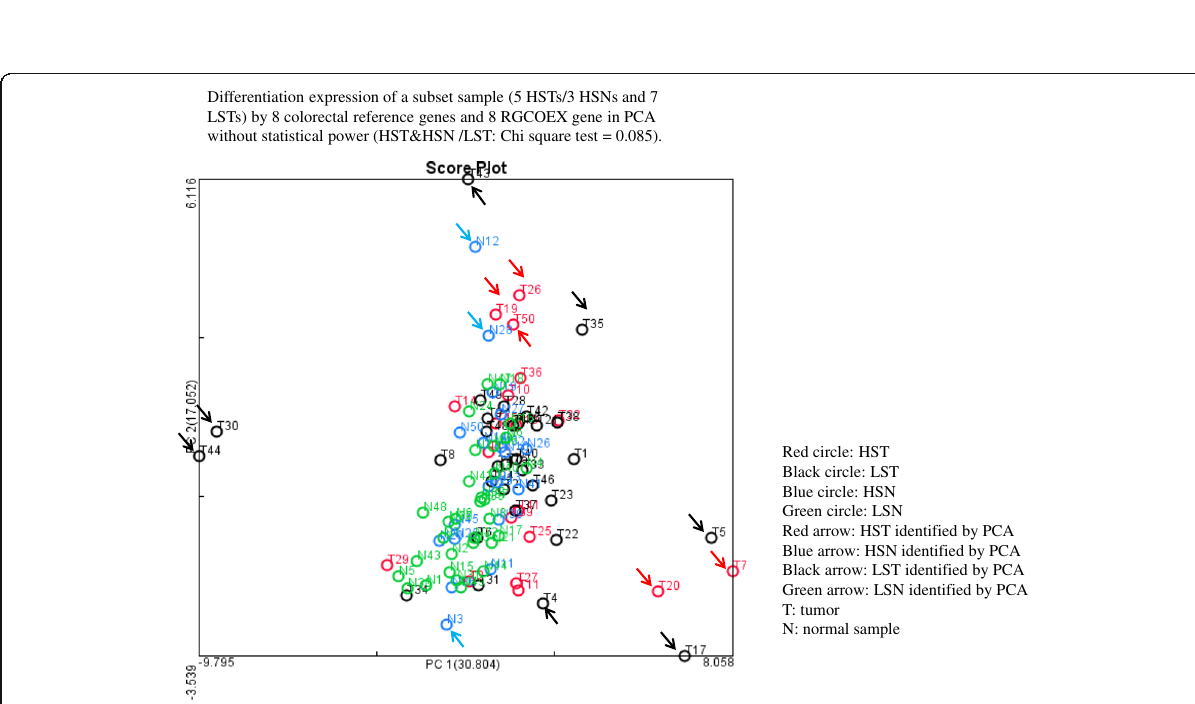
Fig. 5 HCA and PCA analysis of reference genes in 50 CRC pairs (TCGA). a . Differential expression of 21 classical reference genes among 50 CRC pairs (TCGA) in HCA. b . No differential expression of 42 reference genes among 50 CRC pairs (TCGA) in HCA